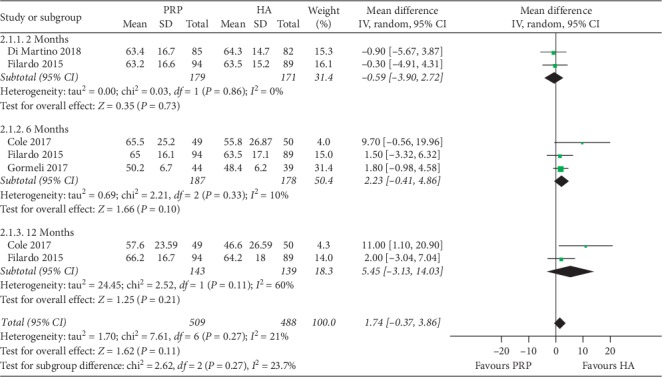
Forest plots showing the comparison of the effects of PRP and HA on IKDC score at 2nd, 6th, and 12th months of follow-up in overweight patients with knee OA. IKDC: International Knee Documentation Committee.